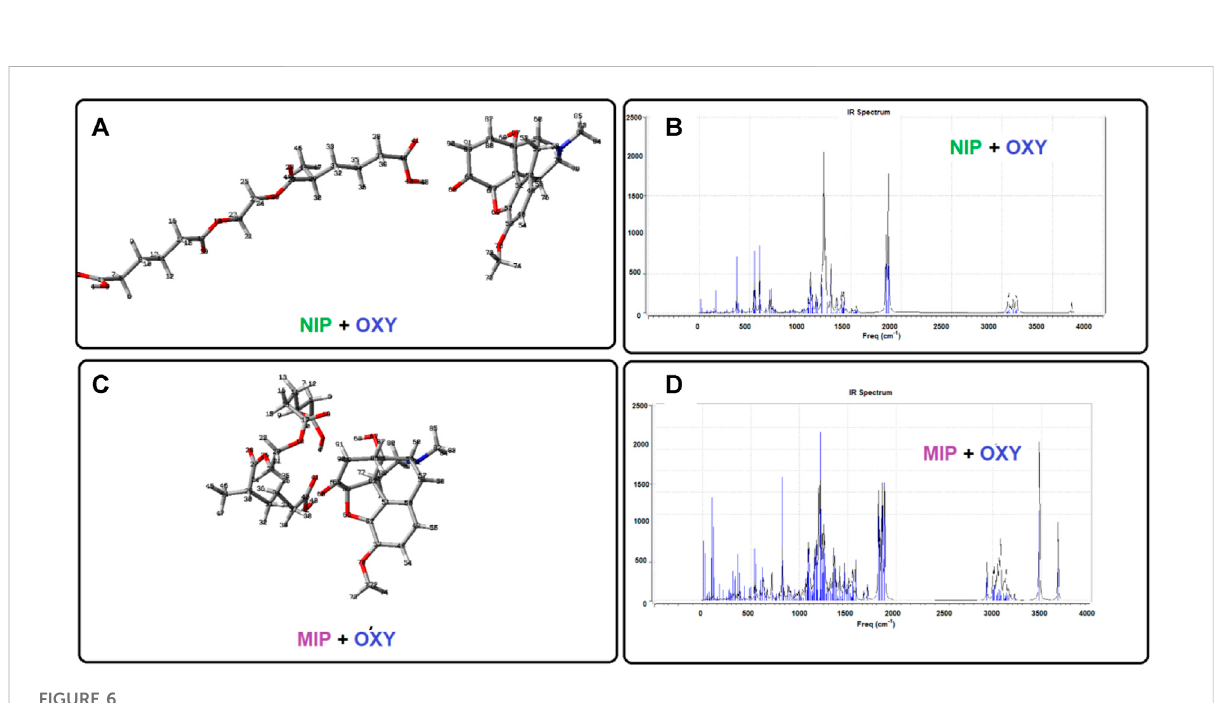
FIGURE 6 The optimized structures as well as their calculated IR spectrums obtained by the DFT